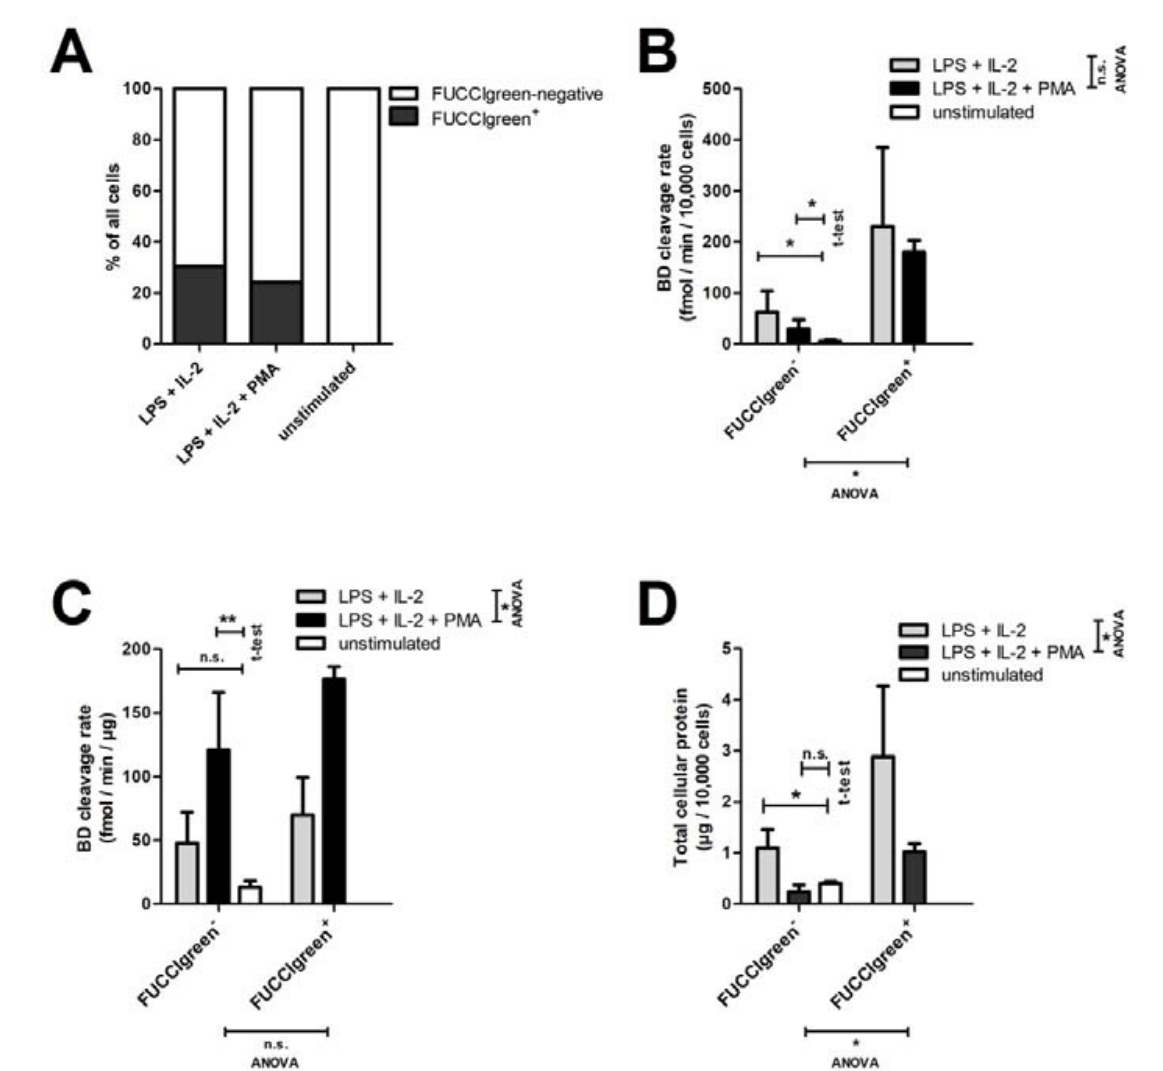
Figure A1. Influence of cell cycle phase on total BD cleavage activity. FUCCI cell cycle reporter trans- genic mice report cells in S/G 2 /M phase of the cell cycle by green fluorescence (FUCCIgreen + ), while cells in G 1 phase do not feature green fluorescence (FUCCIgreen-negative) [61]. Spleen cells of three FUCCI mice were isolated, treated and analysed as described in Materials and Methods. ( A ) Fraction of FUCCIgreen + cells upon stimulation; ( B ) RNase H2 activity normalized to cell number in B cells in S-/G 2 -/M-phase (FUCCIgreen + ) versus FUCCIgreen-negative B cells; ( C ) RNase H2 activity normal- ized to total cellular protein in B cells in S/G2/M-phase (FUCCIgreen + ) versus FUCCIgreen-negative B cells. ( D ) Amount of protein per cell in B cells in S-/G 2 -/M-phase (FUCCIgreen + ) versus FUCCI − B cells. Cells stimulated with LPS and IL-2 possessed significantly more protein per cell than cells stimulated with LPS, IL-2 and PMA. FUCCIgreen+ cells possessed significantly more cellular protein per cell than FUCCIgreen-negative cells. Increase of cellular protein from FUCCIgreen-negative to FUCCIgreen+ cells was about 2.6-fold. Only stimulation with LPS + IL-2 significantly increased the amount of total cellular protein in FUCCIgreen-negative cells. mean ± SD is shown for B cells of three mice (two pipetting replicates each); significance was tested via unpaired two-tailed t -test, or 2-way ANOVA, as indicated in the graphs: ** p < 0.01, * p < 0.5; n.s. not